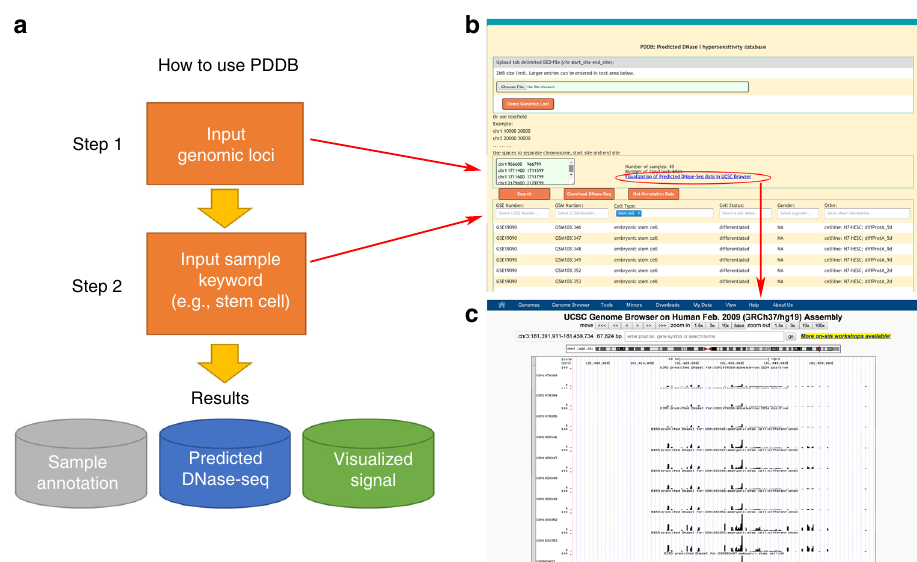
Fig. 5 The predicted DNase I hypersensitivity database (PDDB). a Flowchart illustrating how to use PDDB. Step 1: provide a list of genomic loci of interest. Step 2: provide keywords in one or multiple annotation fi elds (e.g., type “ stem cell ” in the “ Cell Type ” column) to search for samples of interest. PDDB will return predicted DH for the queried loci and samples along with sample annotation and data for visualization. b Web interface of PDDB. Users can download the predicted DH data by clicking the “ Download DNase-seq ” button. The sample annotation data can be downloaded by clicking the “ Get Annotation Data ” button. c By clicking the “ Visualization of Predicted DNase-Seq data in UCSC Browser ” link in the PDDB web interface (red circle in b ), one can display the predicted DH signal in the UCSC genome